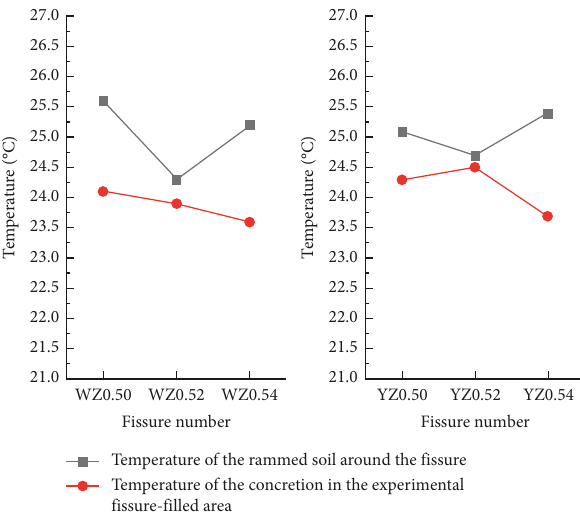
Temperature of the rammed soil around the fissure Temperature of the concretion in the experimental fissure-filled Figure 9: Analysis results for the infrared